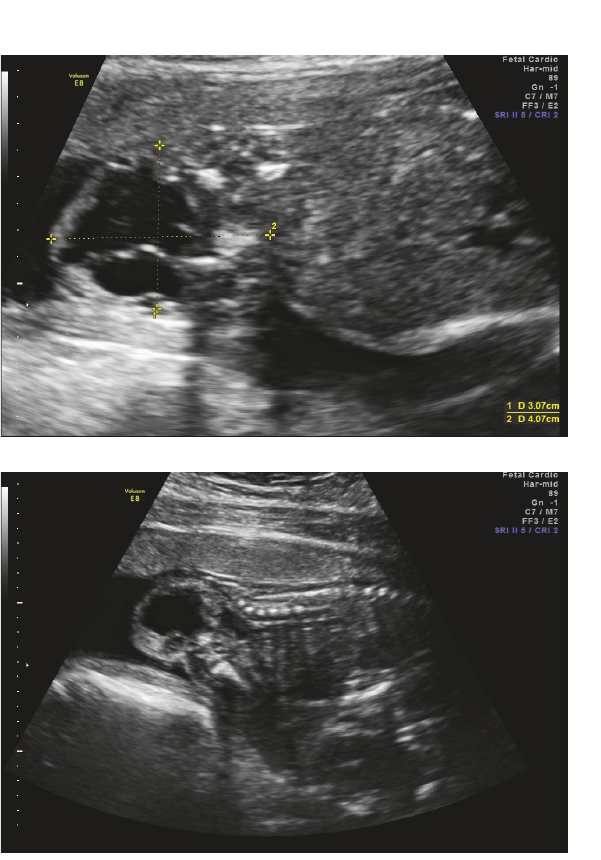
date, there have been two other cases of SCT associated with Trisomy 13 postnatally outside to the